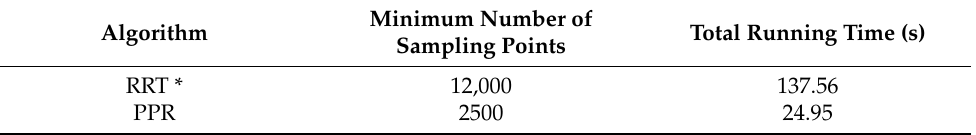
Table 2. Comparison of the planning results obtained by the RRT * and PPR algorithms.